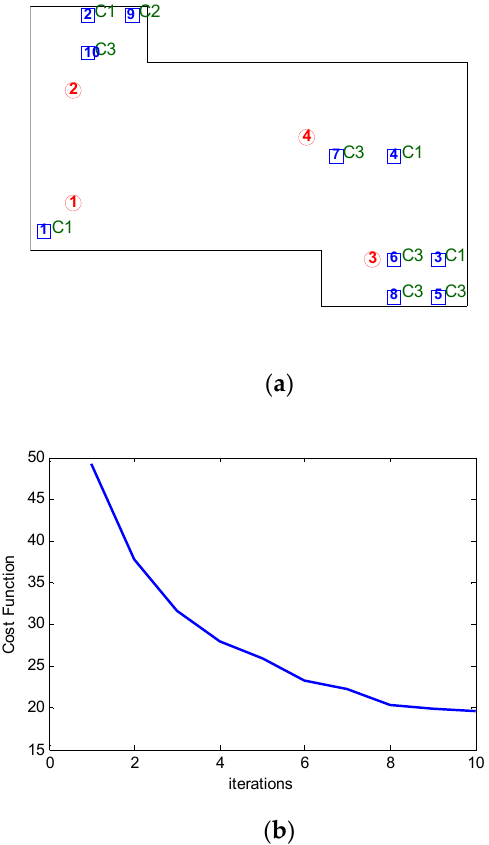
Figure 12. Application of the ANN within the GA optimization process. ( a ) Optimized decap configuration and placement. ( b ) Decreasing trend of the cost function.